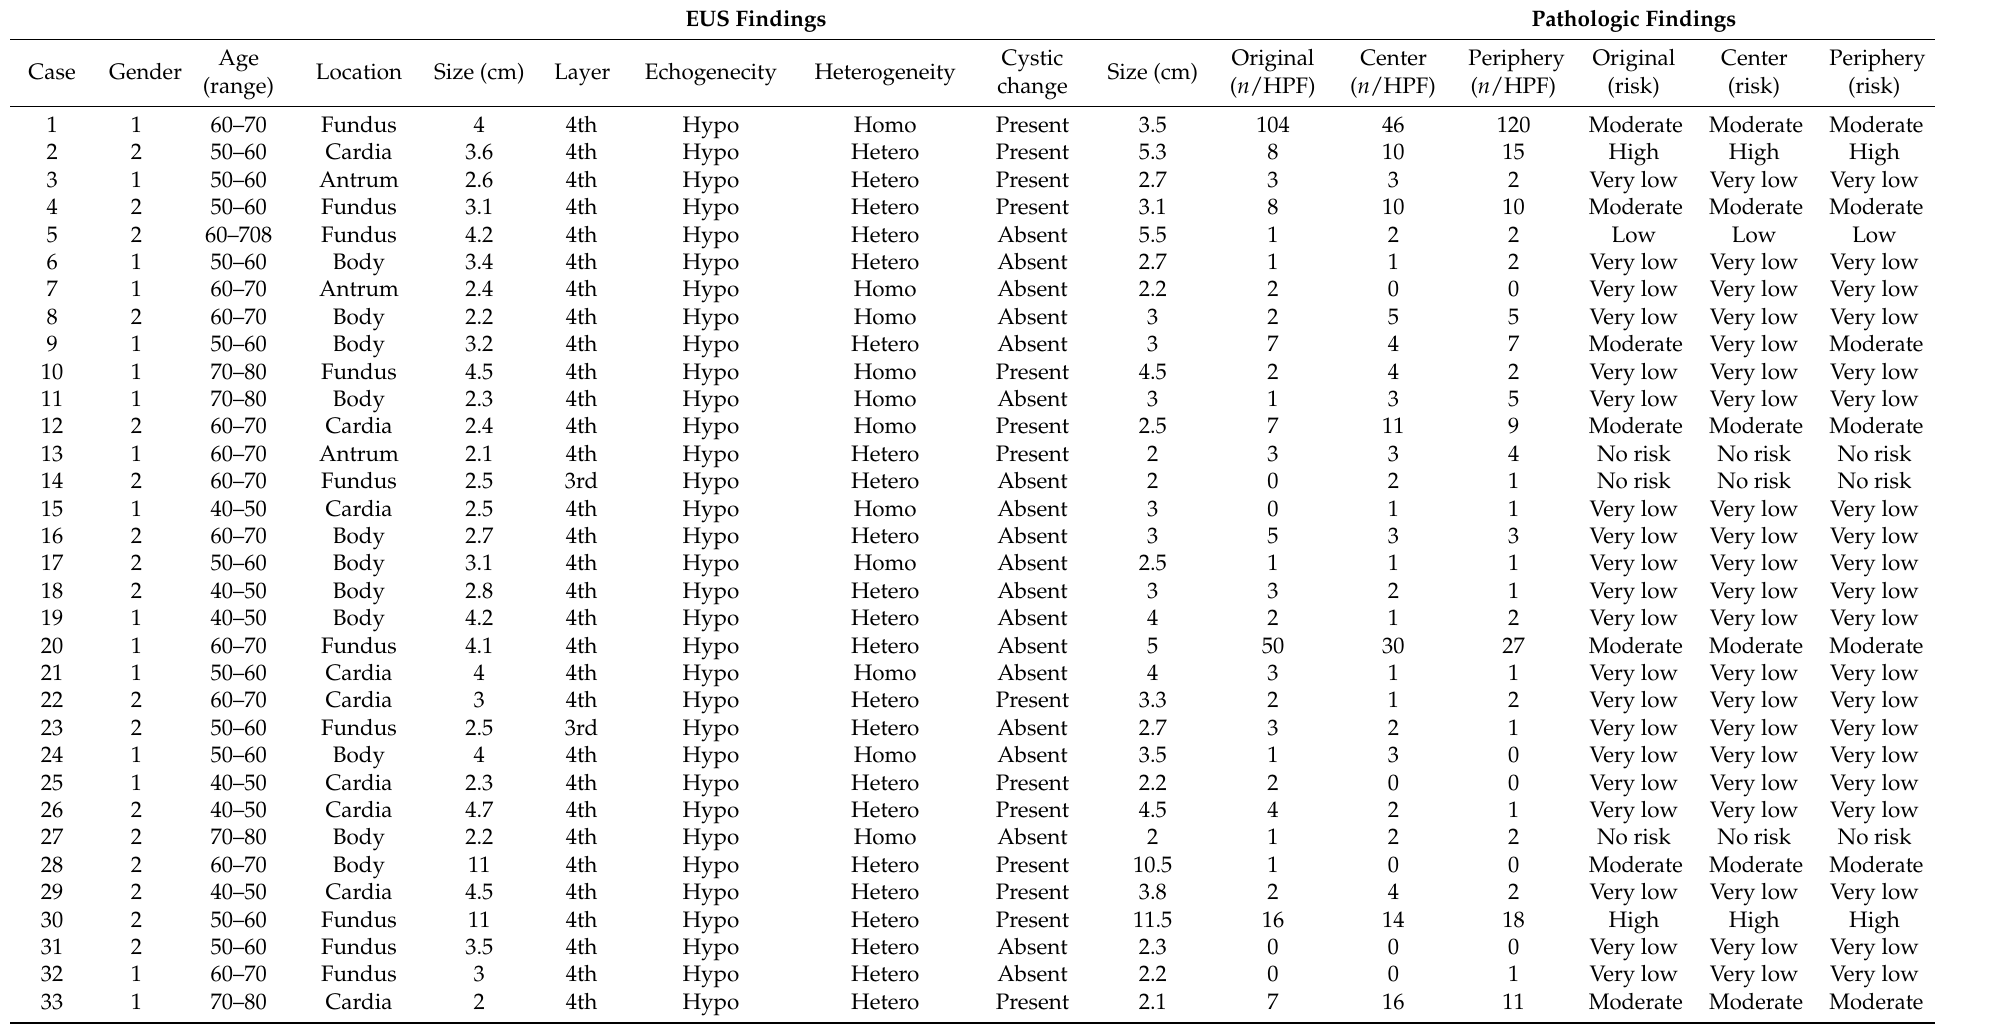
Table 3. Endoscopic ultrasound and pathological findings for total 37